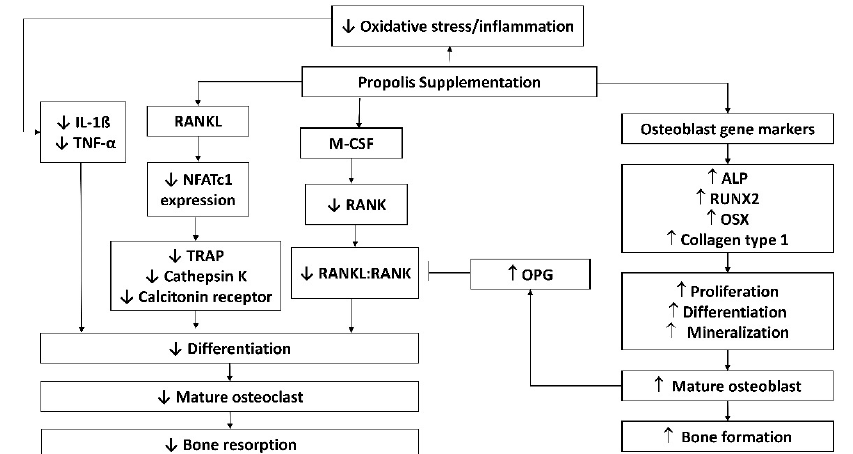
Figure 1. Possible molecular mechanisms of propolis in protecting against bone loss. Abbreviations: ALP, alkaline phosphatase; IL-1 β , interleukin-1 beta; M-CSF, macrophage colony-stimulating factor; NFATc1, nuclear factor of activated T-cells; OPG, osteoprotegerin; OSX, osterix; RANK, receptor activator of nuclear factor-kappa B; RANKL, RANK ligand; TNF- α , tumour necrosis factor-alpha; TRAP, tartrate-resistant acid phosphatase.